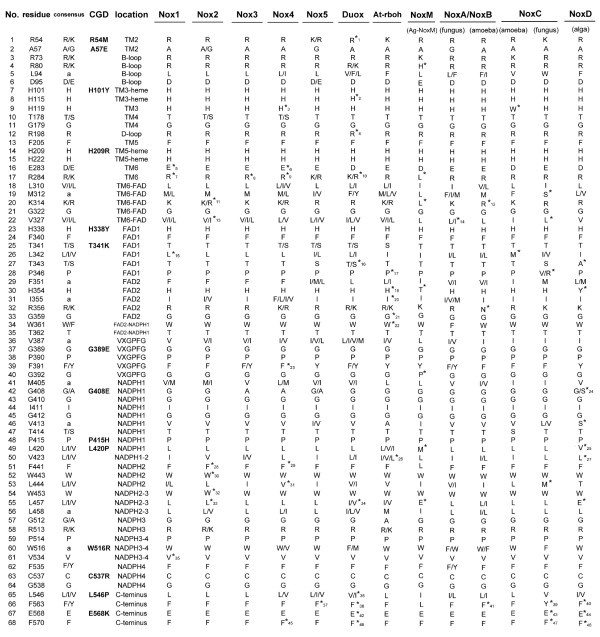
Identification of amino acid residues conserved in all Nox/Duox proteins. The single letter amino acid code is used, and consensus amino acid residues and locations are identified based on the alignment in Additional file 5. In the column labeled "consensus", "a" refers to hydrophobic side-chain amino acids. In the column labeled "location", "TM" refers to TM α-helix; and "TM3-heme" and "TM5-heme" refer to predicted heme-ligating histidine residues. NADPH1-2, NADPH2-3, and NADPH3-4 refer to amino acids that connect each canonical NADPH sub-region. Ag refers to A. gambiae. Point mutations in Nox2, which occur in variants of X-linked CGD, that correspond to the identified conserved amino acids are indicated. Exceptions to consensus residues are indicated by asterisks and are listed in Additional file 11.